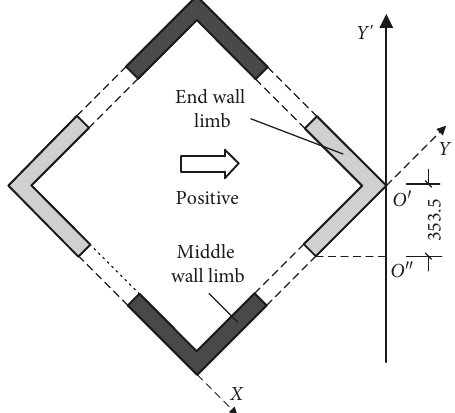
Figure 16: Coordinate system of end wall